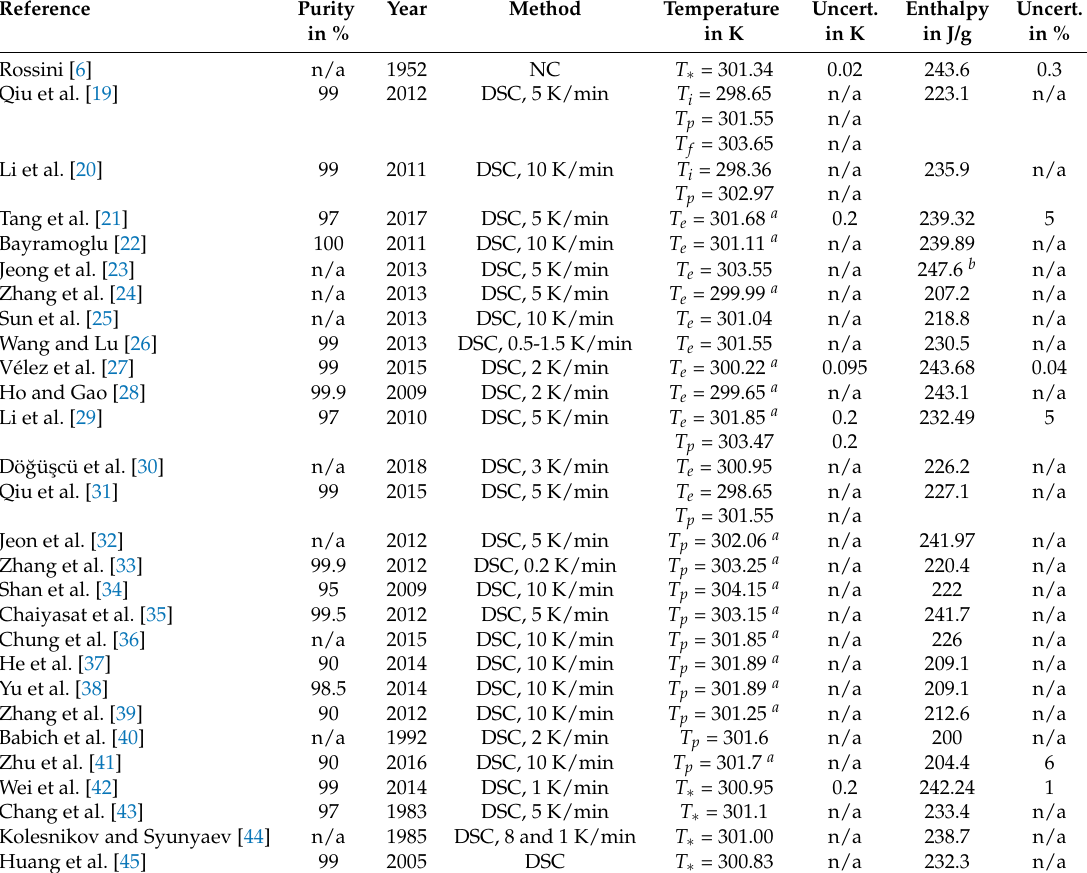
Table 1. Summary of melting temperature and enthalpy data from the